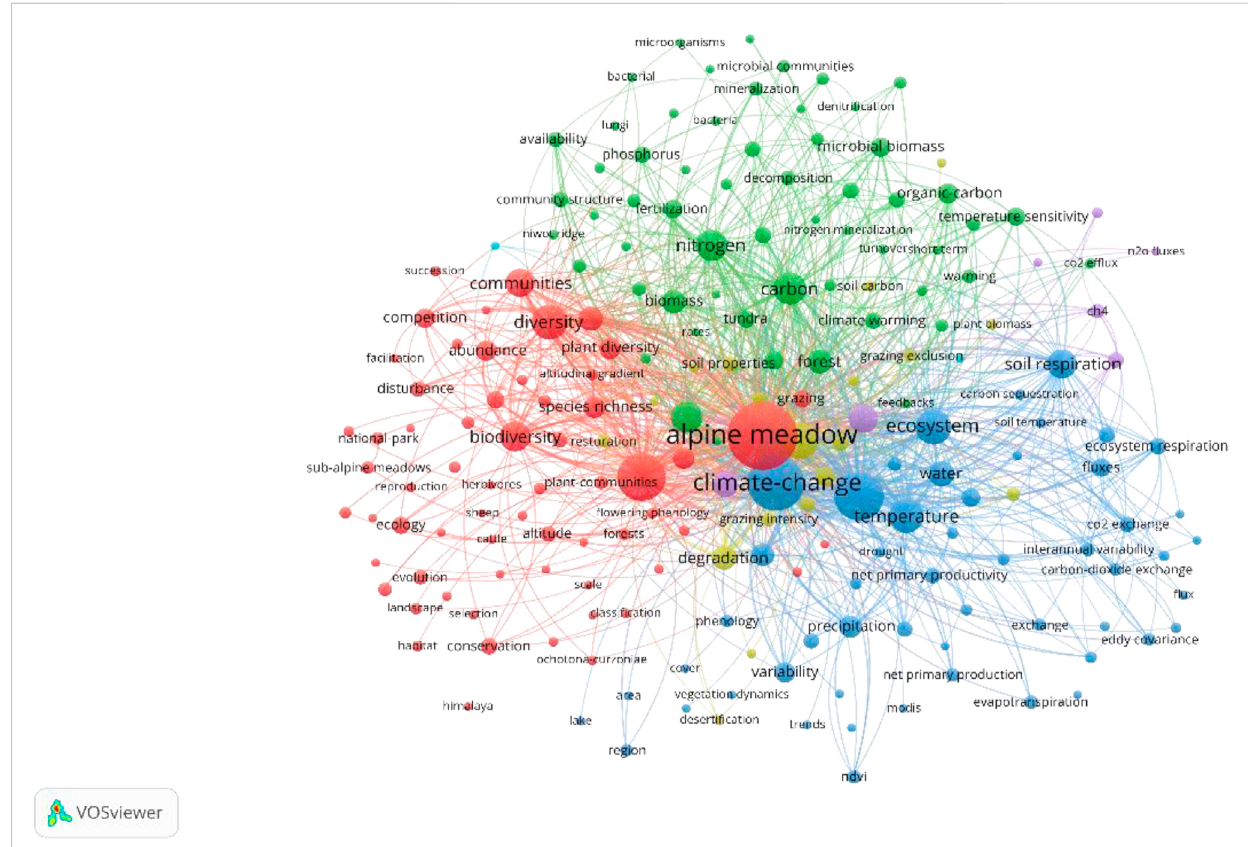
FIGURE 8 Cooccurrence network mapping of keywords related to alpine